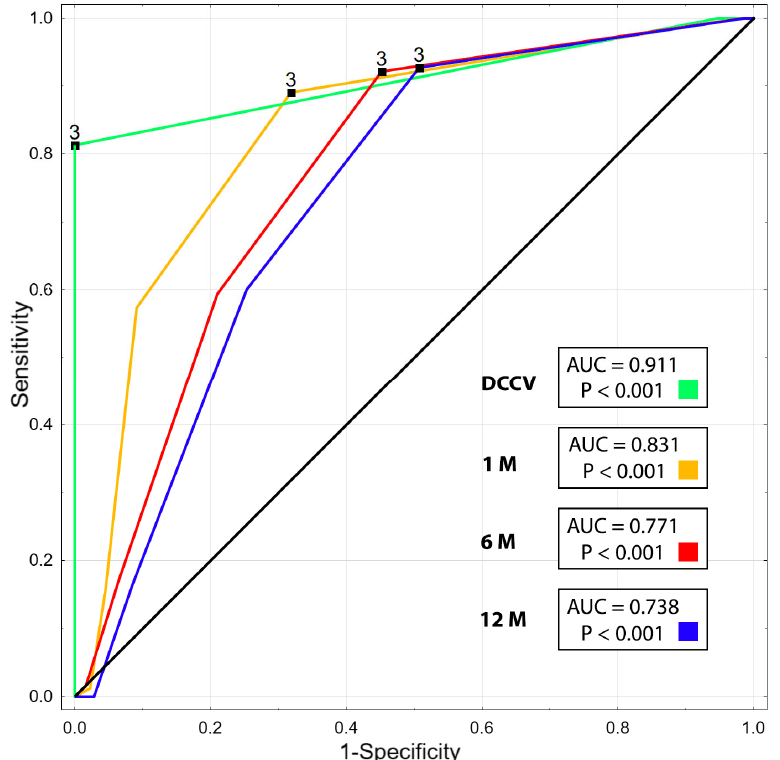
Figure 4. Receiver operating characteristic curve analysis of left atrial wall motion velocity for pre ‐ dicting the efficacy of direct current cardioversion and sinus rhythm maintenance at 1, 6, and 12 months.